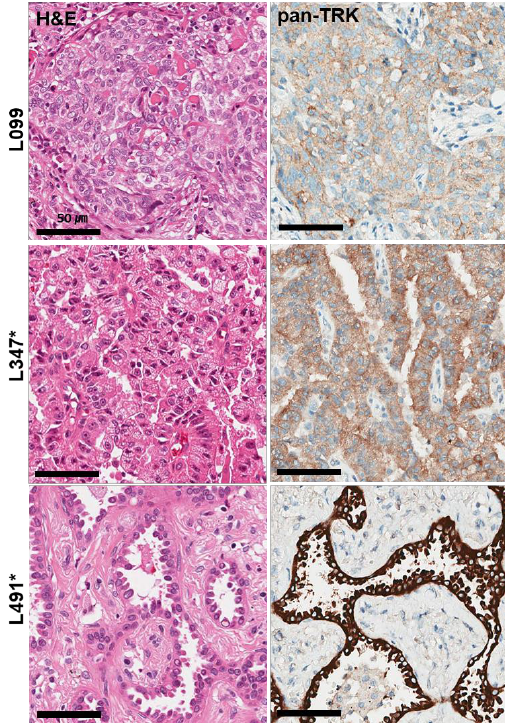
Figure 1. Histological and immunohistochemical findings of three TRK expression cases observed in 510 NSCLC samples. Pan-TrK IHC with moderate cytoplasmic and membranous staining